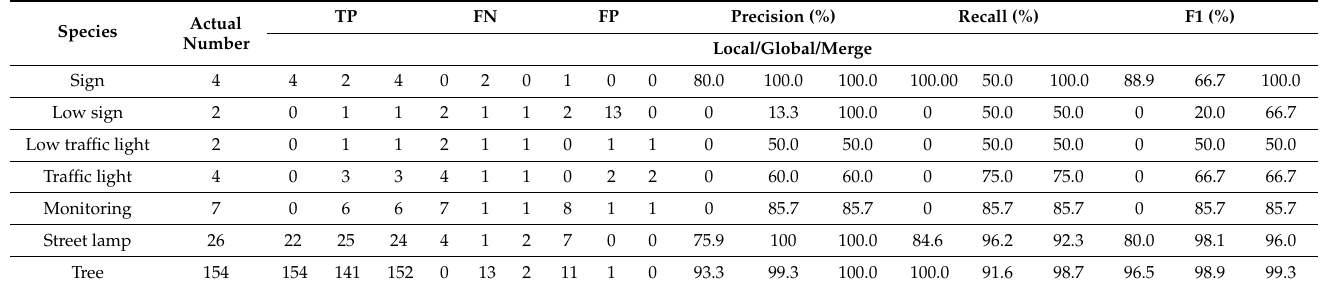
Table 2. Classification accuracy evaluation table. Each column in the table represents a different pole-like object type. Each TP, FN, FP, precision, recall, and F1 have three values, which represent the classification result based on the local, global, and